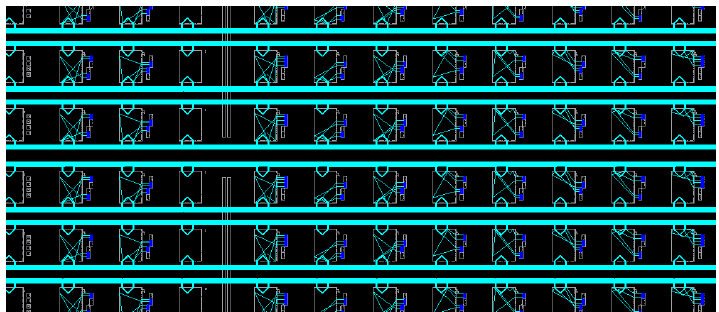
Figure 18. Test pattern of the hex line & PIPs along the horizontal direction.